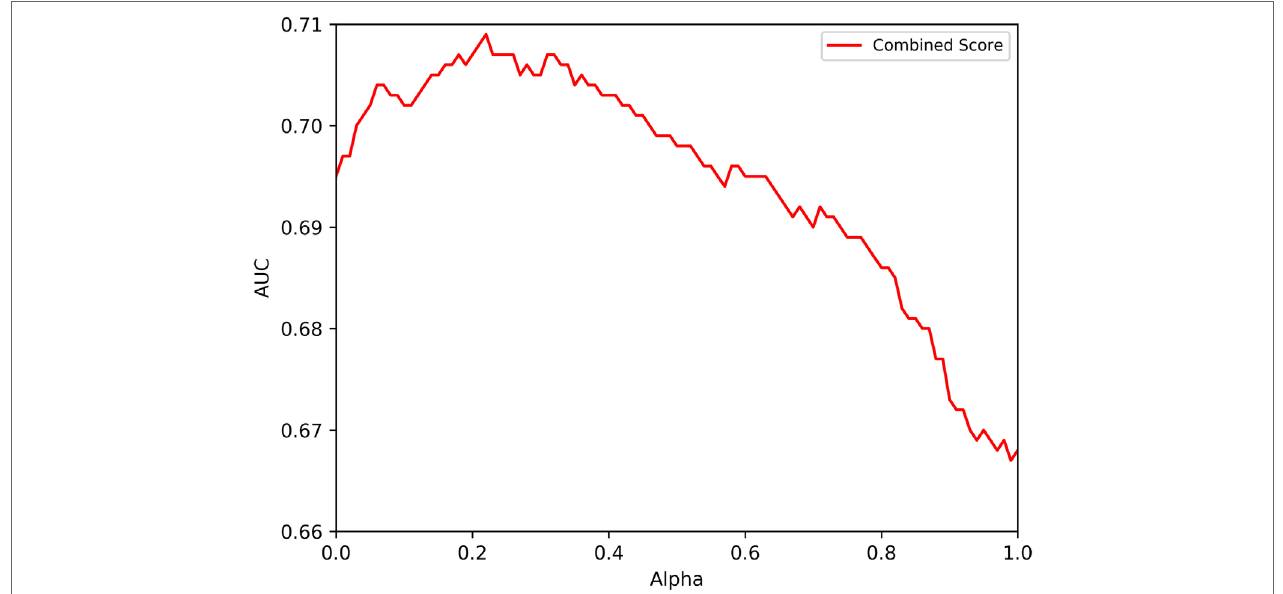
FigUre 2 | Predictive performances obtained combining HLA binding and immunogenicity scores. The figure shows the performance dependency on an α coefficient used to combine HLA binding and immunogenicity scores. The model trained on the training dataset described in the text and validated on independent literature datasets, also described in the